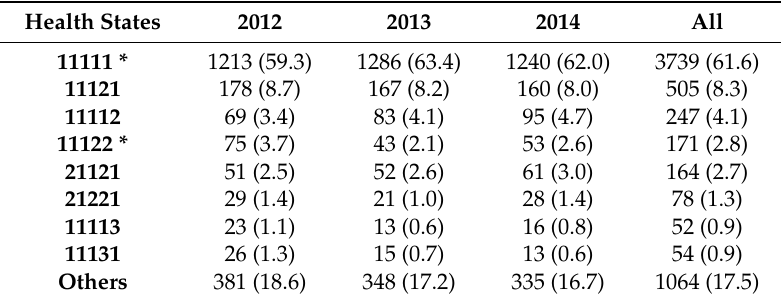
Table 4. Frequencies of most reported health states.